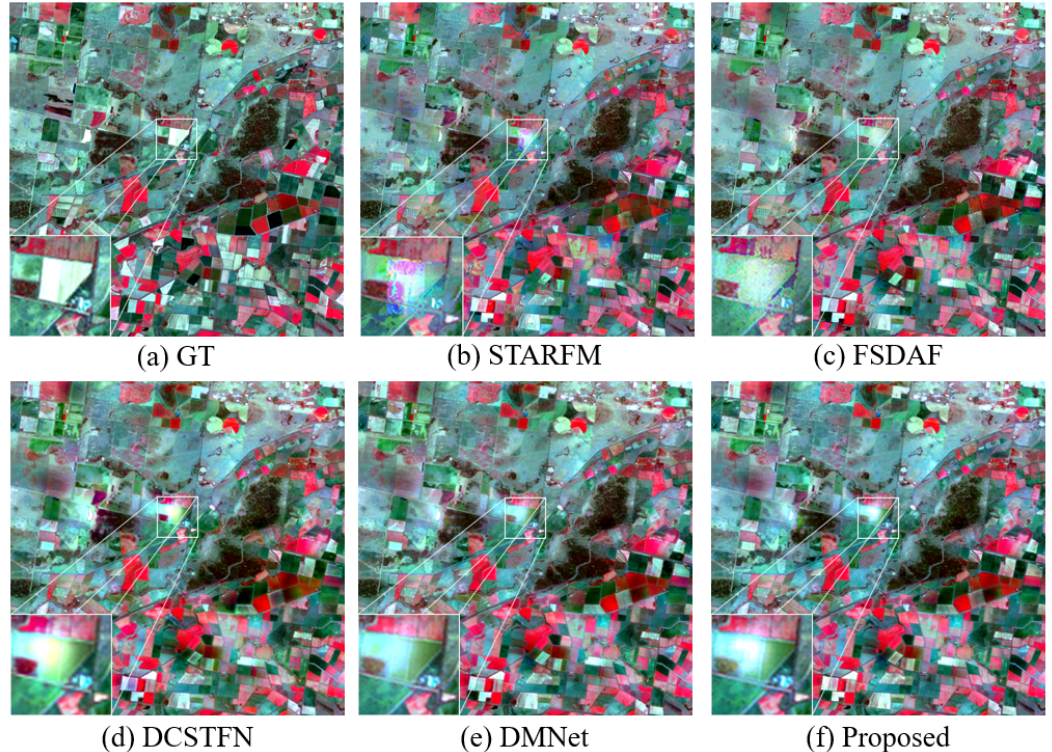
Figure 8. Predicted results of the high-spatial resolution image (26 April 2002) on the CIA [46] dataset. Additionally, the comparison methods include STARFM [13], FSDAF [21], DCSTFN [27] and DMNet [18], which were represented by ( b – e ) in the figure, respectively. Moreover, the GT is the ground truth represented by ( a ), and ( f ) is our proposed STF